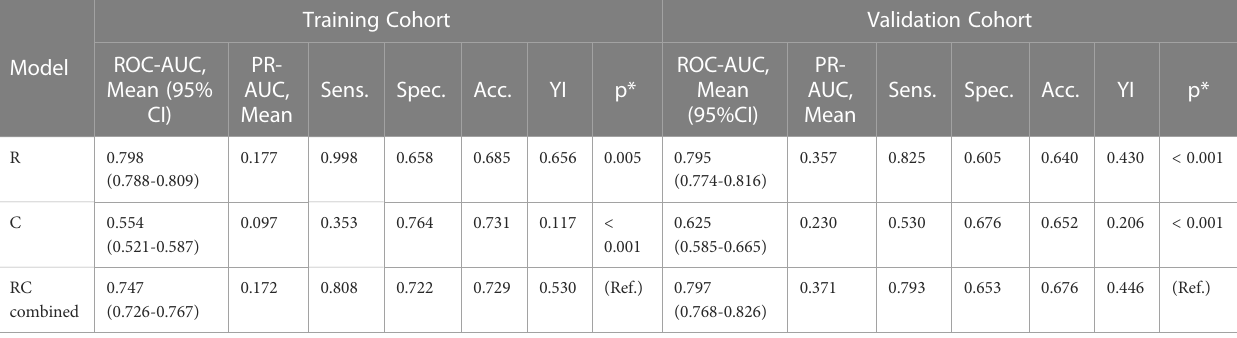
TABLE 3 Predictive performance of the R, C and RC combined